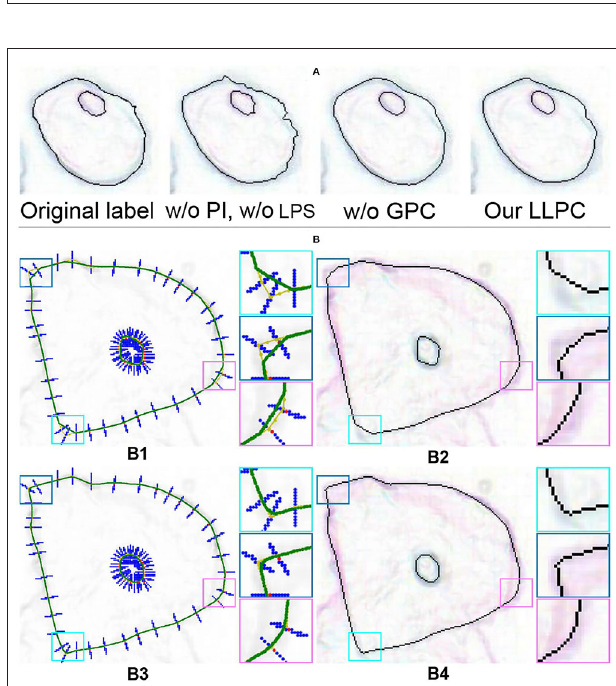
FIGURE 12 | (A) Ablation of gradient-guided point correction. “GPC” is gradient-guided point correction. (B) Visual comparison of different label correction methods. (B1) The green curves generated by piecewise curve fitting (w/o LPS); (B2) The discrete edge sampled from the curves in (B1); (B3) The curves smoothed by LPS; (B4) The discrete edges without curve sampling.